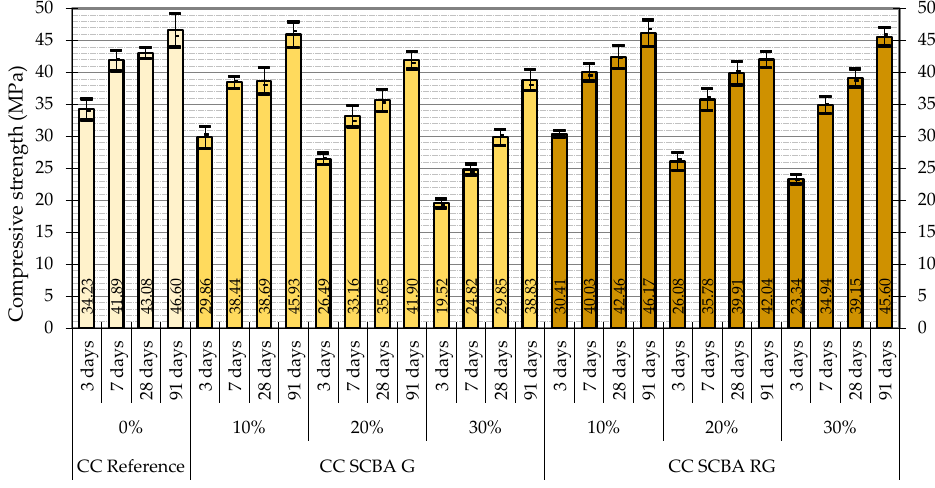
Figure 12. Compressive strength of mortars with a water/binder factor fixed in weight.